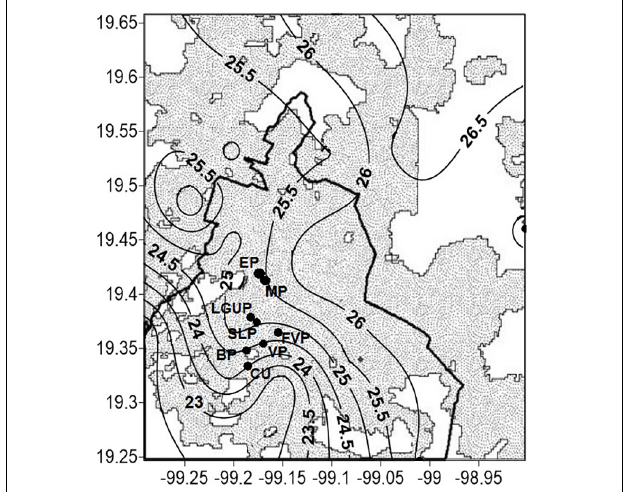
FIGURE 1 | Location of five study sites of Mexico City where measurements were carried out and included the parks: (1) España (EP); (2) Mexico (MP); (3) Luis G. Urbina (LGUP); (4) Bombilla (BP); and (5) Ciudad Universitaria (CU). The shaded area shows distribution of air temperature ( ◦ C) in the metropolitan area of Mexico City. The wide, solid line represents the division between the state of Mexico and Mexico City.